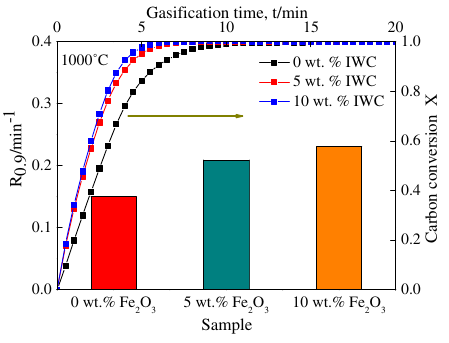
Fig. 2 YCW gasification reactivity under different IWC loading